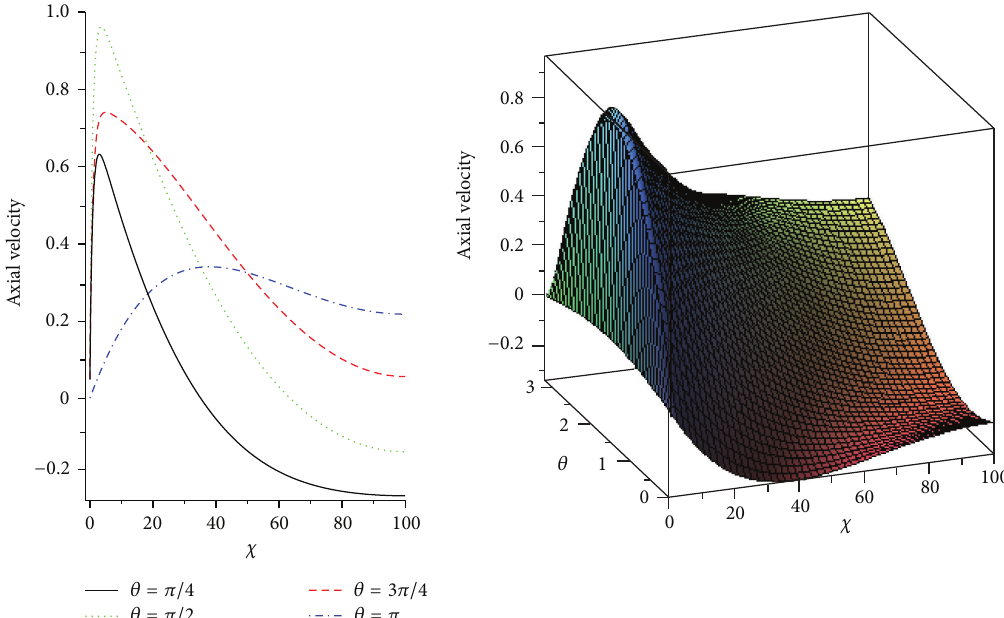
Figure 6: 2D and 3D plots of velocity profile at various instants of time obtained from the model with 𝛼 = 1 , 𝜅 = 0.03, ℓ = 0.05 , and ℎ = 100 𝜆 .